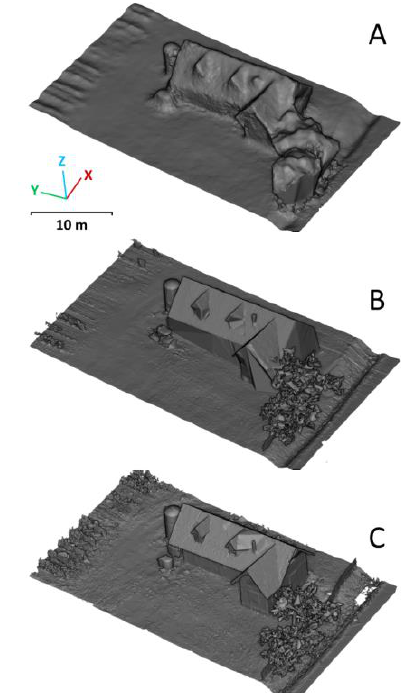
Figure 3. 3D TIN model derived from (A) CRP, (B) ALS, (C) TLS point cloud with correctly determined the orientation of the